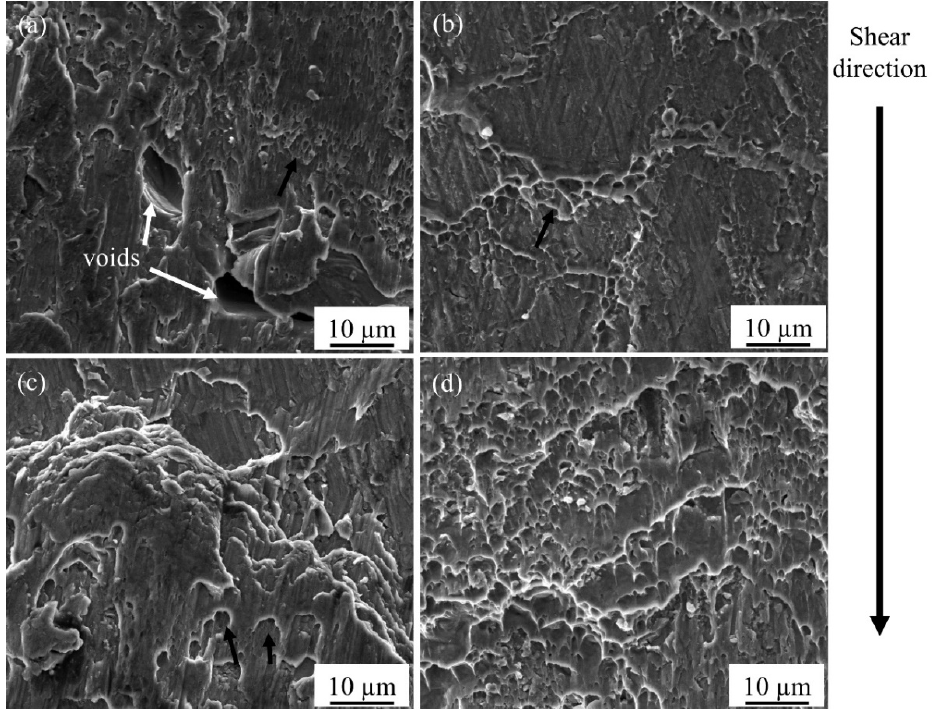
Figure 7. Fractography of the fracture surfaces of AA6061 joints diffusion bonded for 240 min at temperatures of ( a ) 500 °C, ( b ) 510 °C, ( c ) 520 °C, and ( d ) 530 °C.